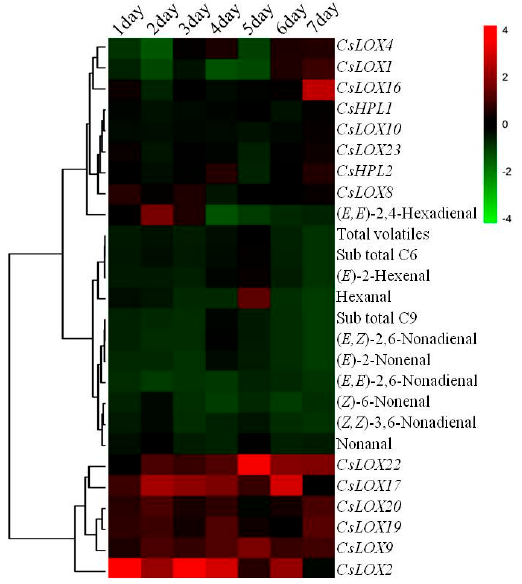
Figure 6. Hierarchical cluster dendrogram and heat map of volatiles content and gene expression folds during N-sufficient and deficient treatments in 9930 leaves. Leaves were sampled at 1, 2, 3, 4, 5, 6 and 7 day after N-deficient treatments. The heat map has been generated based on the fold-change values of volatile contents, CsLOXs and CsHPLs expression level in the treated samples when compared with its unstressed control samples by MetaboAnalyst 3.0 software. The color scale for fold-change values is shown on the right. Values of gene expression folds are means of three biological replicates with three technical replicates. Values of short-chain volatiles are means of three biological replicates.